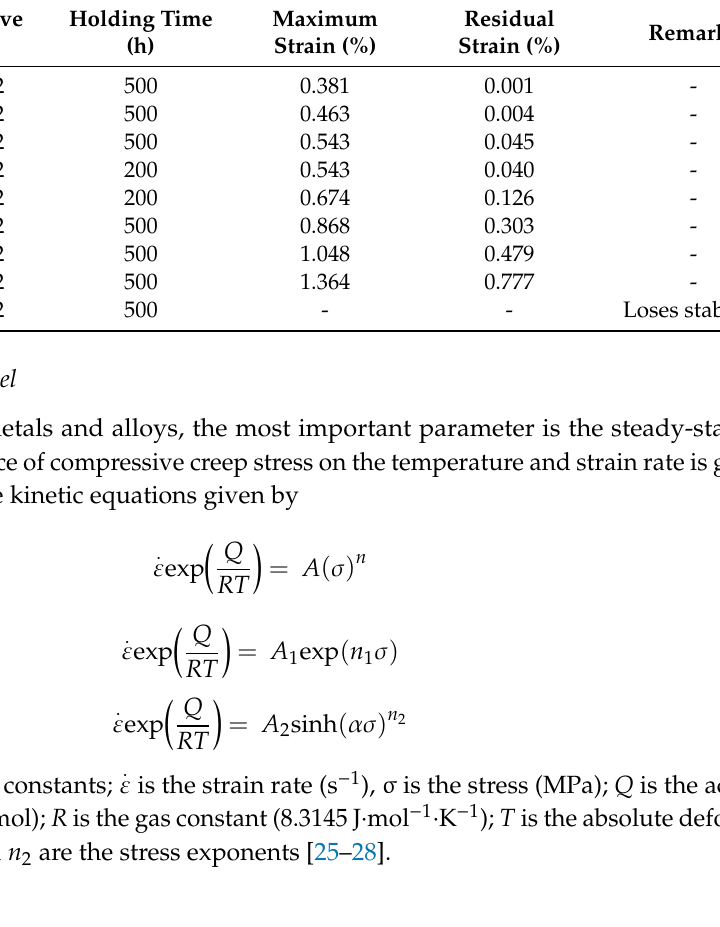
Table 3. Maximum strain and residual strain in compression of TA31